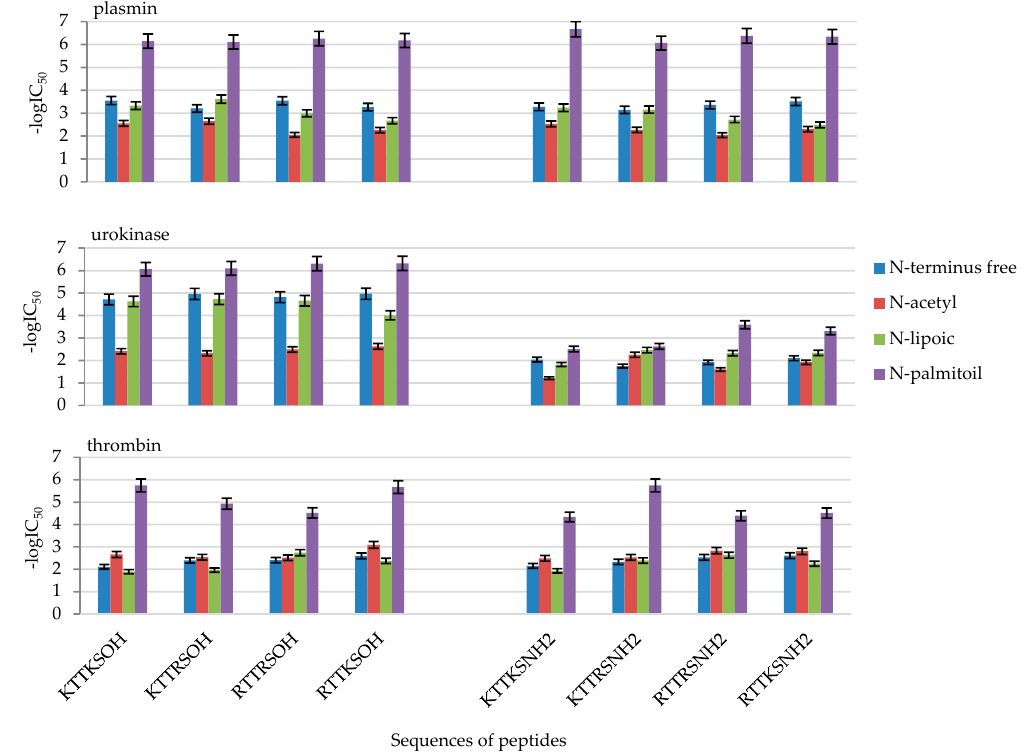
Figure 9. Influence of the synthetized peptides on plasmin, urokinase and thrombin activity with substitution of amino acids in sequences taken into account. Values in the form of -logIC 50 .